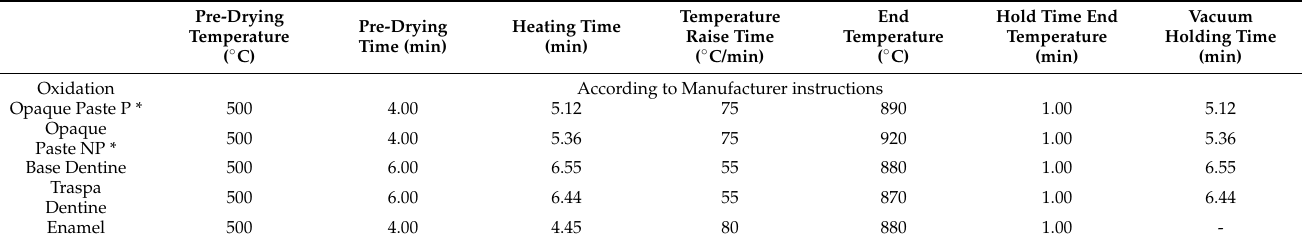
Table 2. Firing chart.